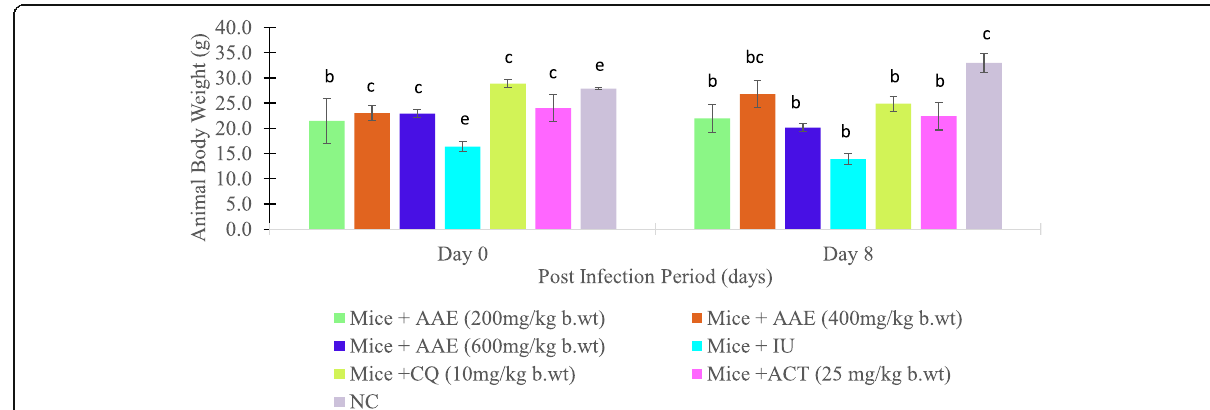
Fig. 5 Effect of aqueous extract of A. aspera on the body weight of mice infected with P. berghei (NK-65). Mice + AAE = infected mice treated with Achyranthes aspera aqueous extract, Con IU = infected mice untreated, Con CQ = infected mice treated with chloroquine (10 mg/kg), Con ACT = infected mice treated with artemisinin (25 mg/kg) and NC = normal control group. Values with different superscript are significantly different at p <